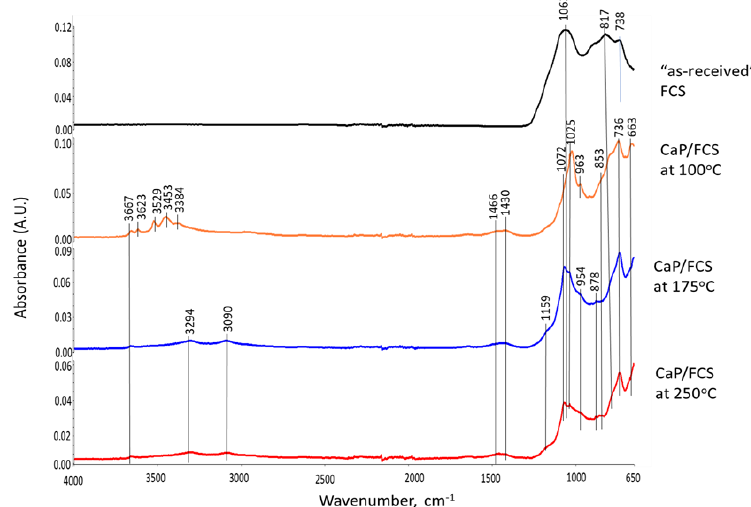
Figure 10. ATR-FTIR spectra for 100-, 175-, and 250 °C-autoclaved CaP/FCS cements. SEM/EDX analysis of the 250 o C-autoclaved sample is shown in Figure 11. At location